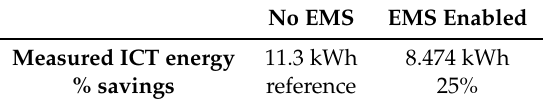
Table 2. Cloud computing data center’s single site energy saving results.